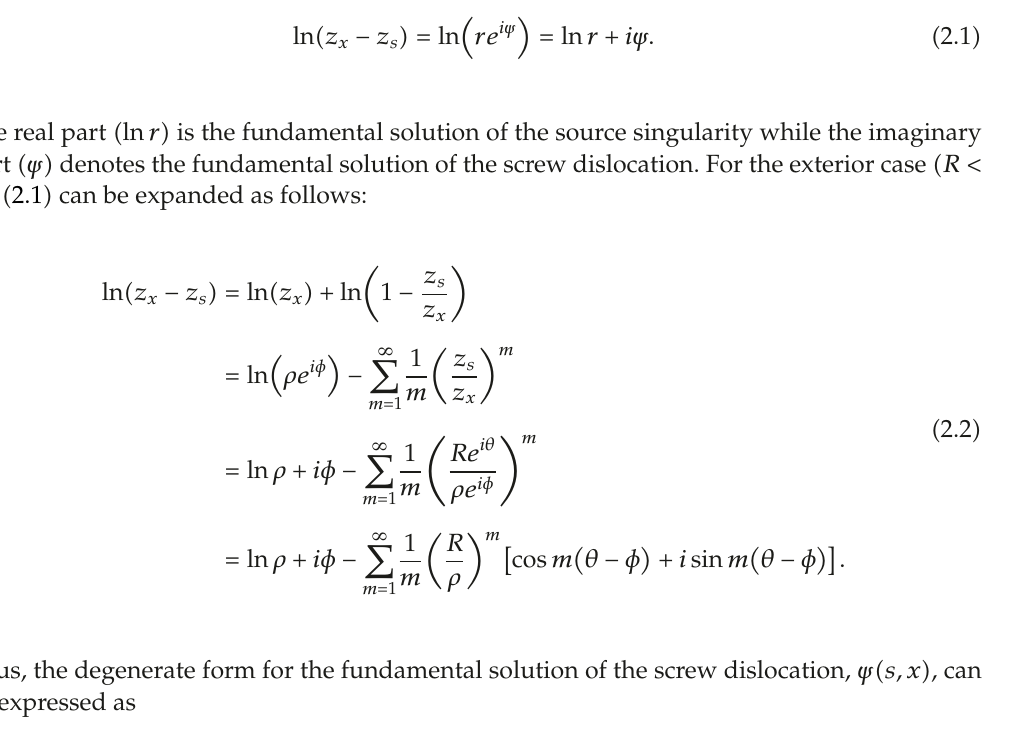
Figure 2. By decomposing the ln (cid:5) z x − z s (cid:6) into real and imaginary parts, we